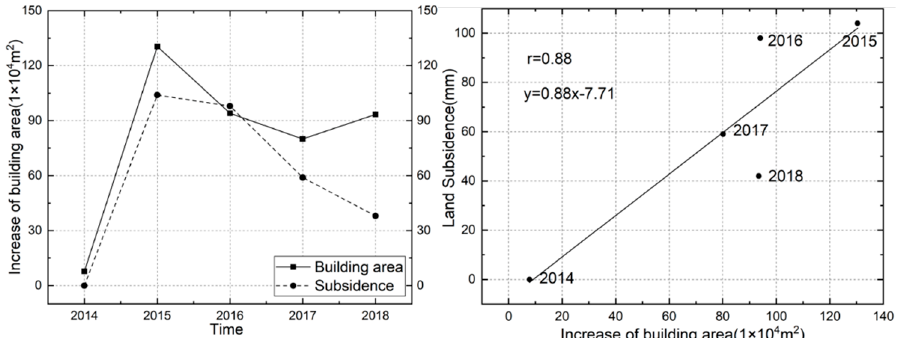
Figure 14. The relationship of the annual increase of building area and land subsidence from 2013 to 2018.